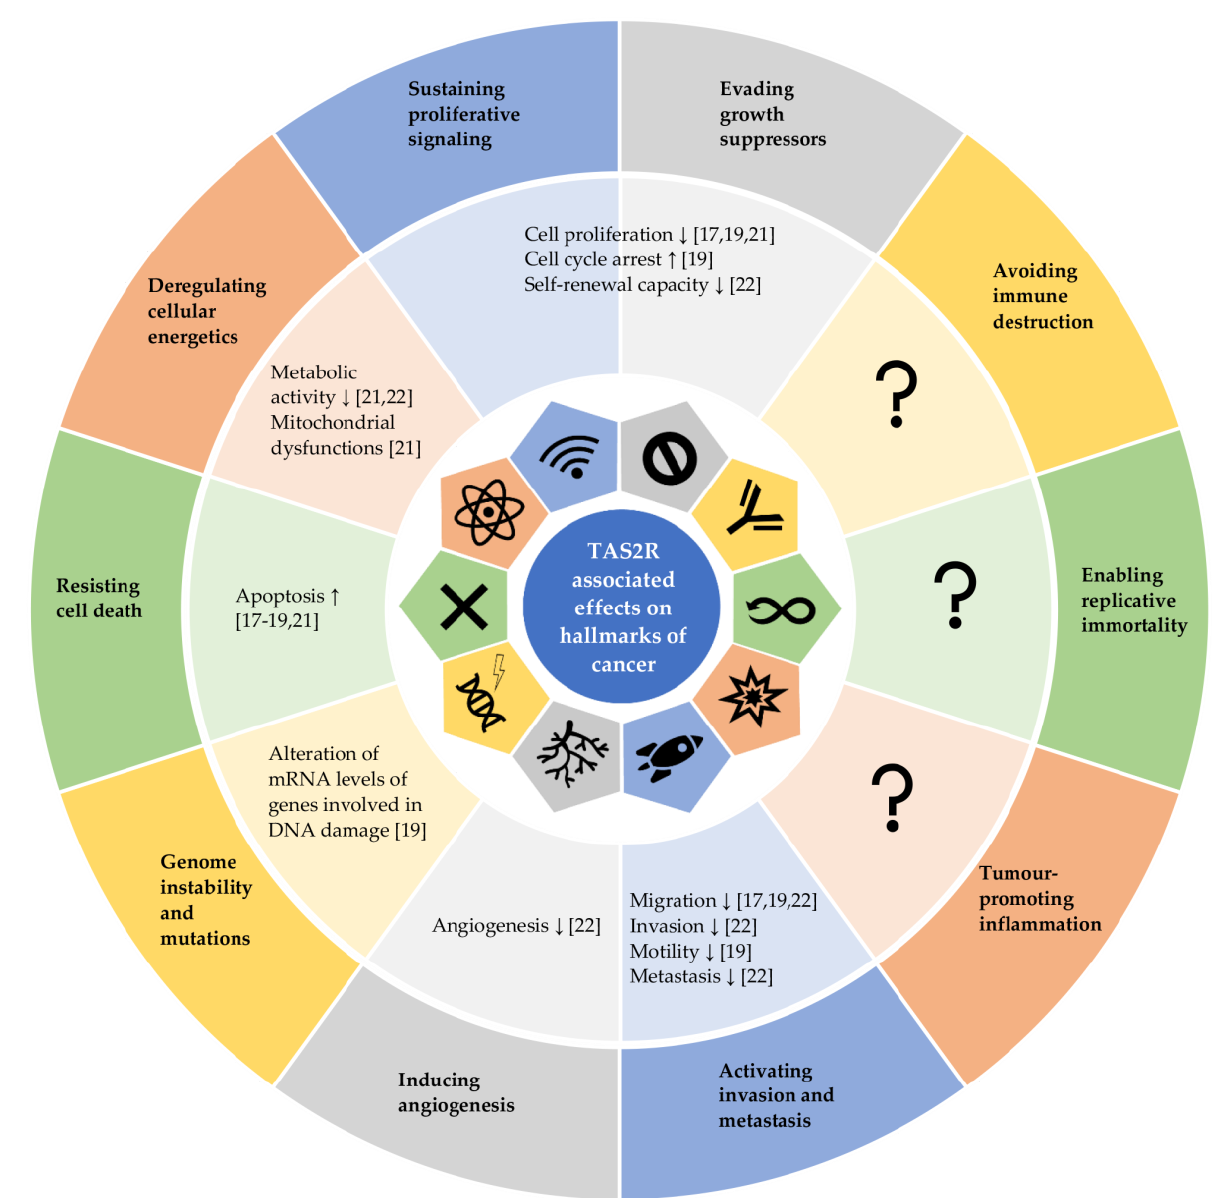
Figure 1. This figure is adapted from Hanahan and Weinberg, 2011 [54] and highlights how agonist-mediated activation of TAS2Rs and/or by overexpression of TAS2Rs can counteract the diverse capabilities of cancerous cells and tissues, known as hallmarks of cancer. ↑ : promoting effect; ↓ : inhibitory